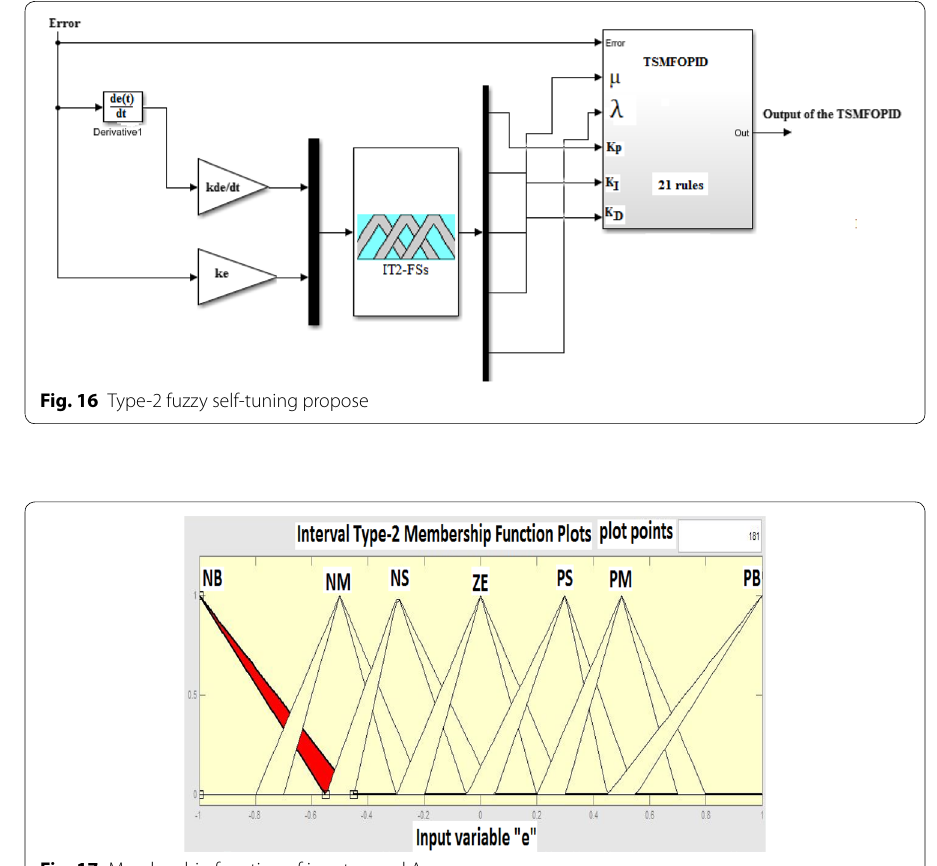
Fig. 17 Membership function of inputs e and Δ